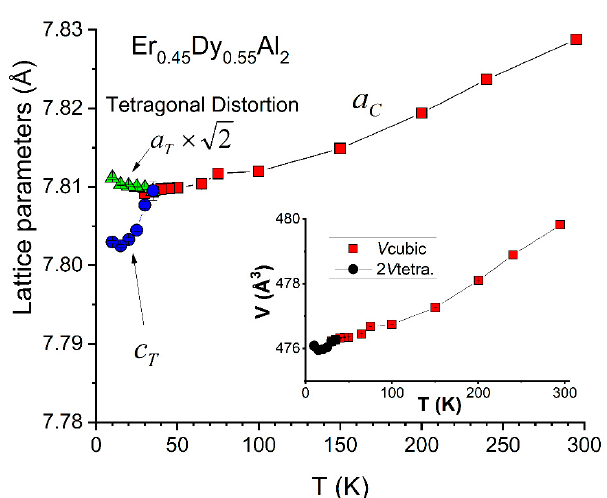
Figure 5. Lattice parameters of Er 0.45 Dy 0.55 Al 2 as functions of temperature. Inset shows the unit cell volume as a function of temperature.